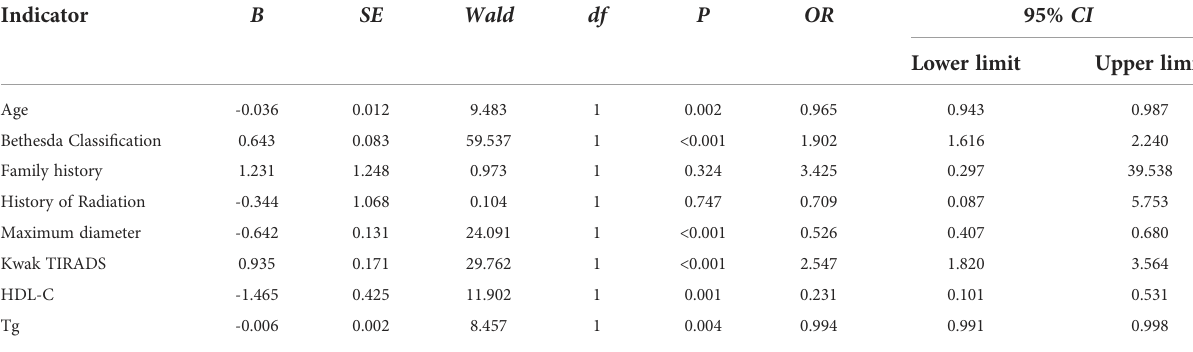
TABLE 2 Multivariate logistic regression analysis of PTC in TN